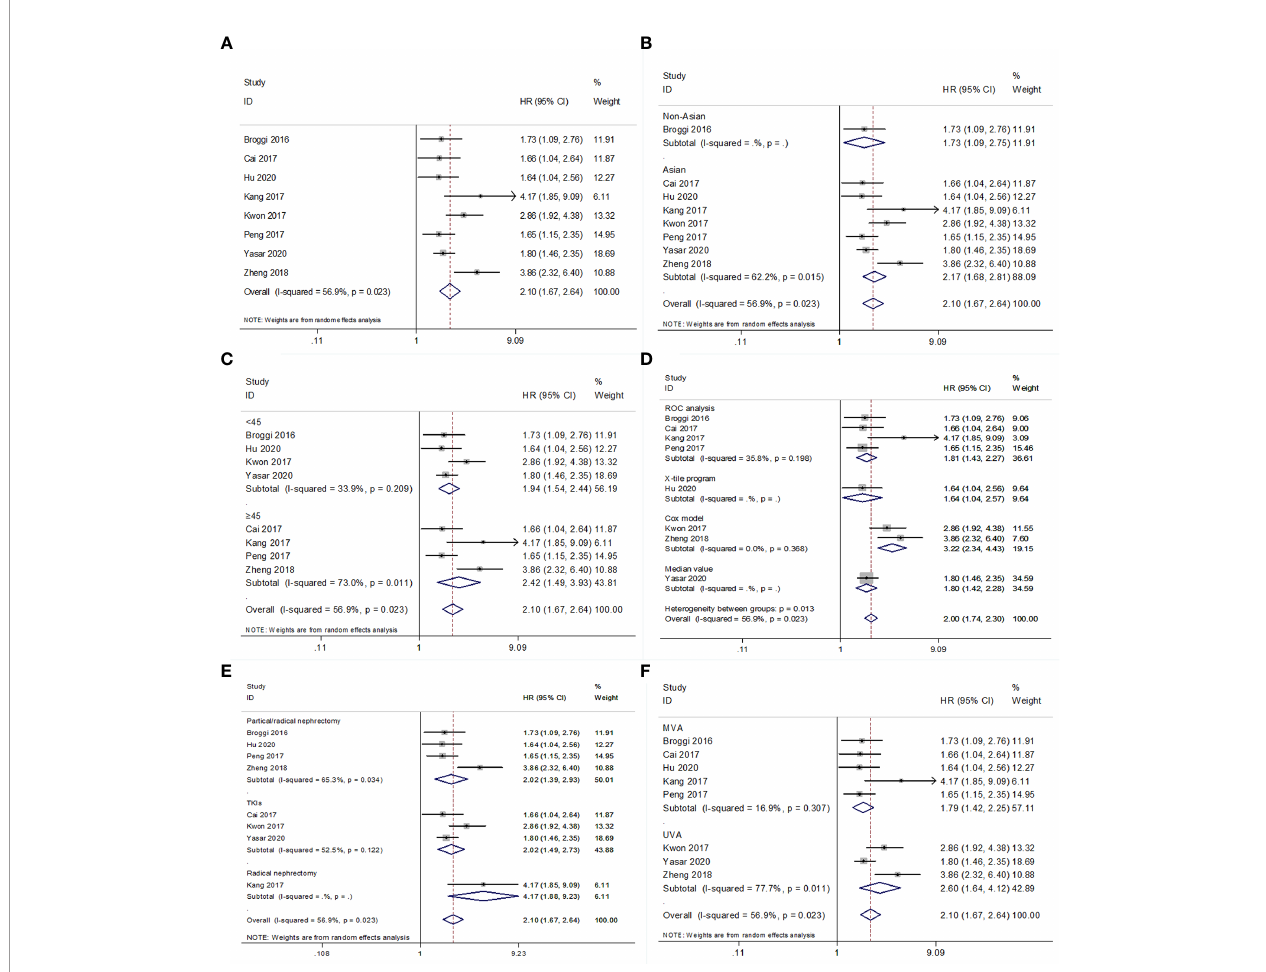
FIGURE 2 | Forest plot examining the association between PNI and OS in patients with RCC. (A) overall patient population; (B) subgroup analysis by various ethnicities; (C) subgroup analysis by various cut-off values of PNI; (D) subgroup analysis by various cut-off value determination methods; (E) subgroup analysis by various treatment methods; (F) subgroup analysis by various survival analysis